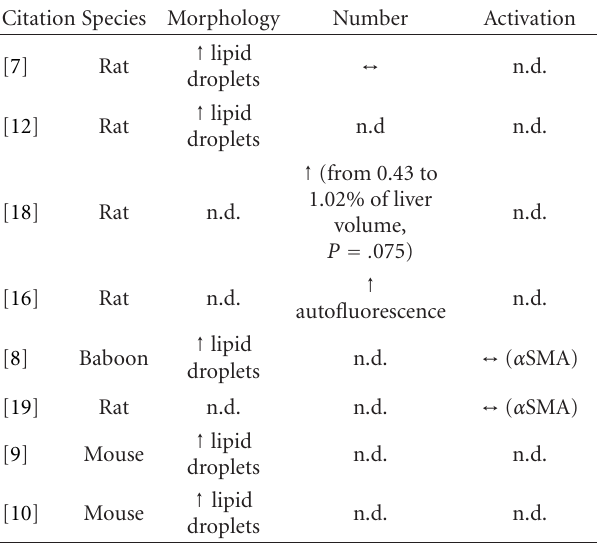
Table 3: The results of previous studies where the e ff ect of old age on HSC was